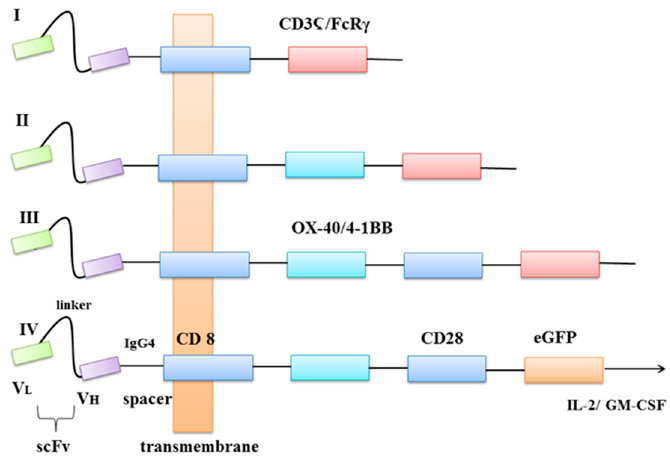
Figure 1. Four generations of CARs. V L —light chain variable domain, V H —heavy chain variable domain, scFv—a single-chain variable fragment, spacer—protein fragments fused together, CD8— transmembrane protein, OX-40—also known as CD134 glycoprotein receptor, tumour necrosis factor receptor superfamily, 4-1BB—glycoprotein receptor tumour necrosis factor receptor superfamily, CD3 Ϛ —protein complex and T-cell co-receptor that is involved in activating both the cytotoxic T cell and T helper cells, FcR γ —receptor for inducing phagocytosis, CD28—a protein that provides costimulatory signals, eGFP—enhanced green fluorescent protein, Il-2—interleukin 2 (cytokine), GM-CSF—granulocyte-macrophage colony-stimulating factor.